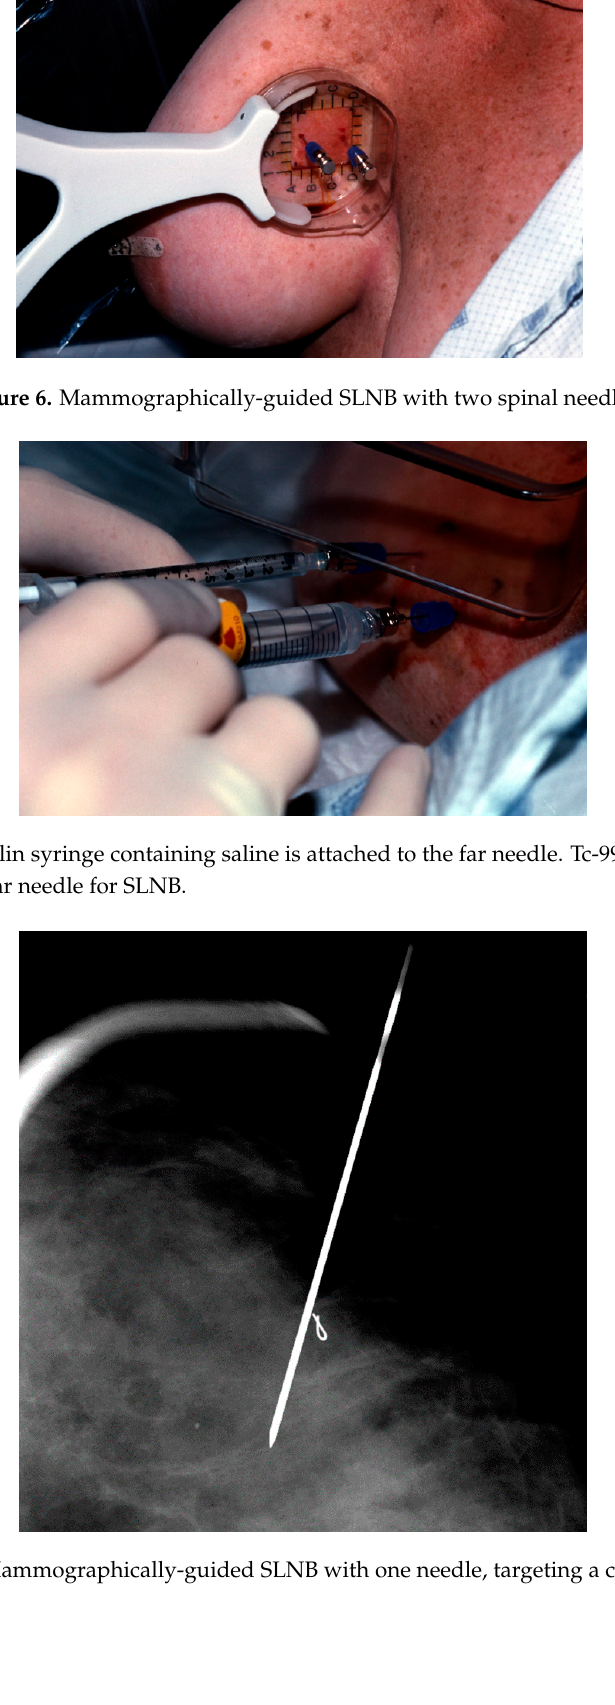
Figure 8. Mammographically-guided SLNB with one needle, targeting a clip marker.